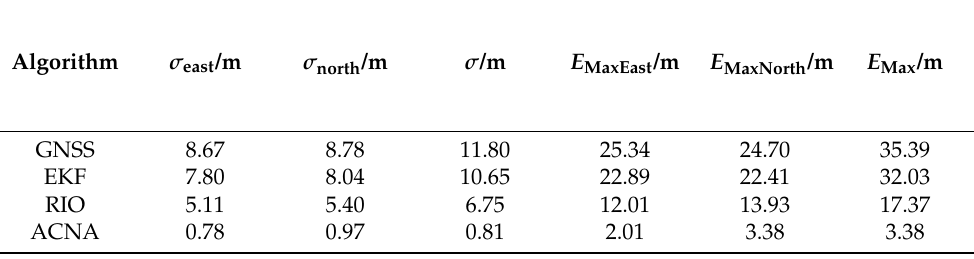
Table 5. The east, north and relative positioning accuracy and maximum error of the three algorithms in the data set Ψ 4